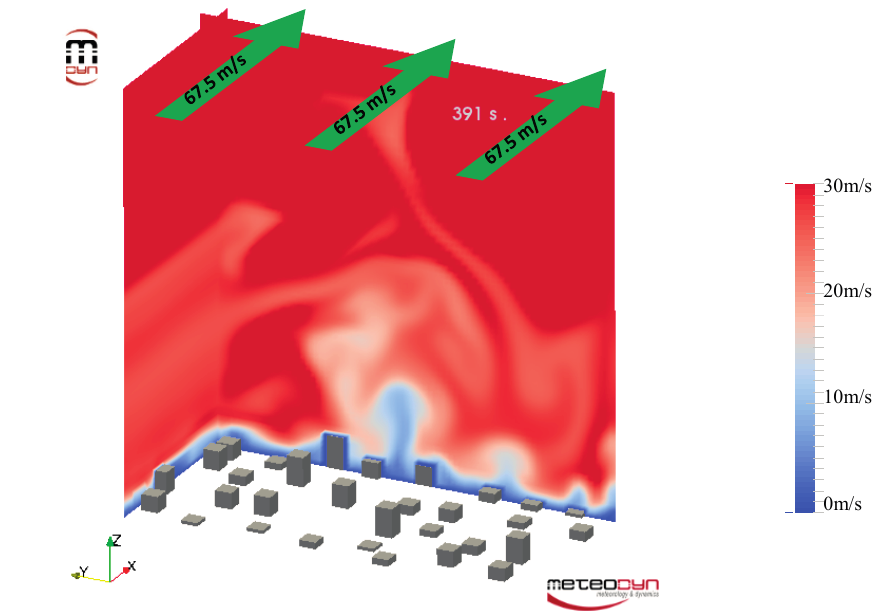
Figure 4. Instant wind field slices in the computational